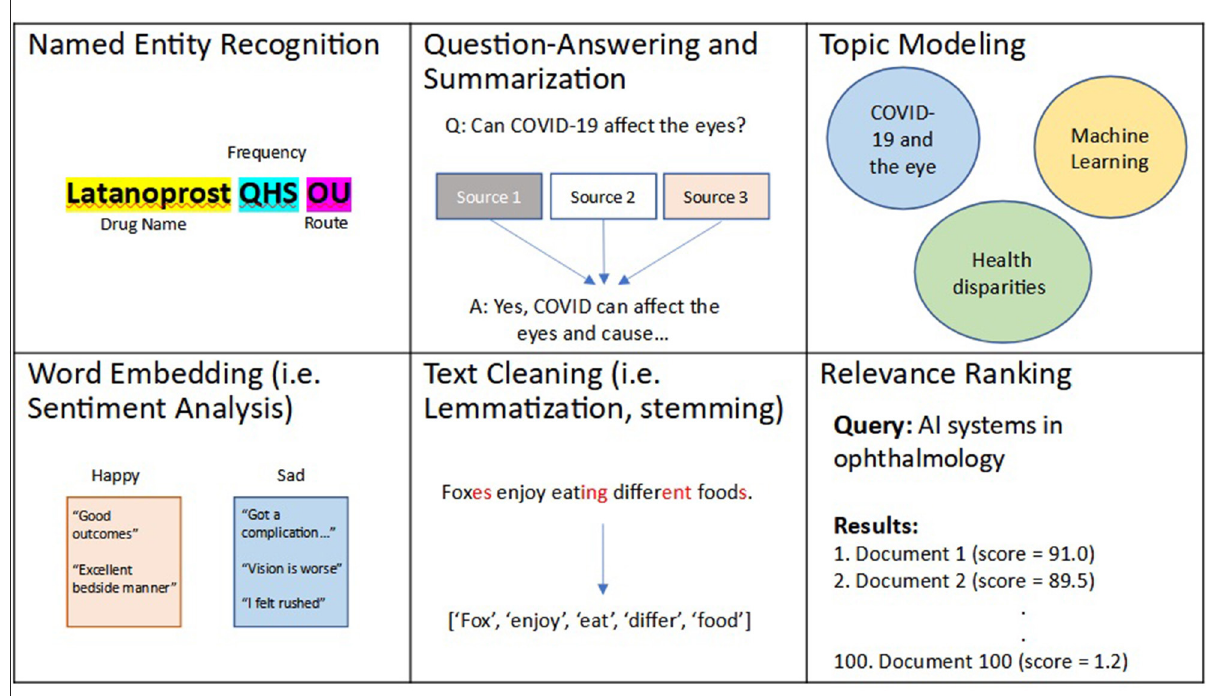
FIGURE2 Examples of natural language processing (NLP) techniques and applications. Natural language processing, or NLP, is an area of artificial intelligence (AI) that deals with processing and analyzing textual data. Several NLP techniques include: relevance ranking, named entity recognition (NER), text cleaning, word embedding, which has applications in question-answering, summarization, topic modeling, among several other use